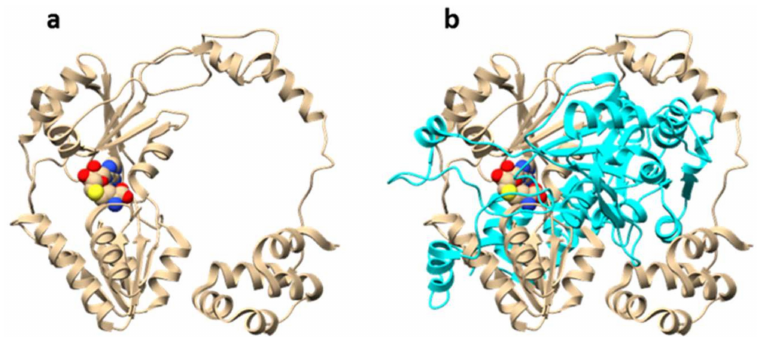
Figure 6. Overall structure of dbOphMA (PDB 6MJF). dbOphMA is OphA homolog from Dendrothele bispora species. ( a ) dbOphMA monomer bound to S -adenosyl homocystein (SAH), ( b ) interlocking organization of dbOphMA dimer.